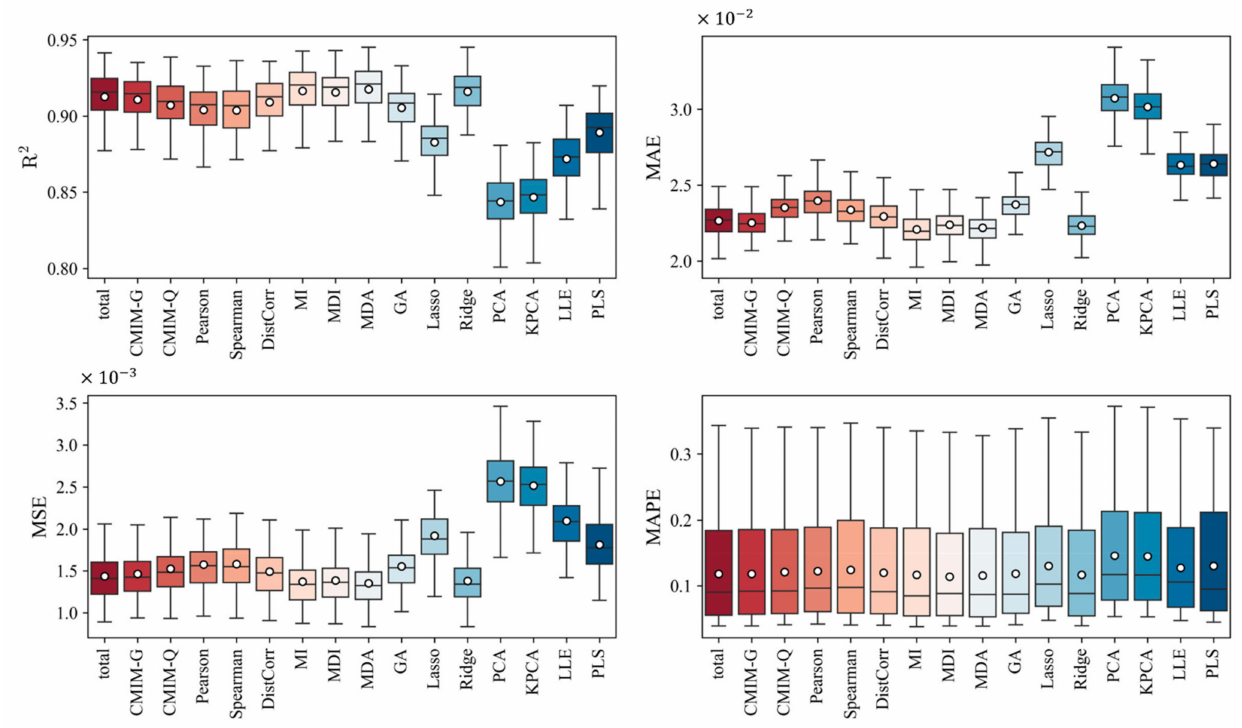
Figure 9. Comparison of metrics obtained by different methods with RF on Y GAS .